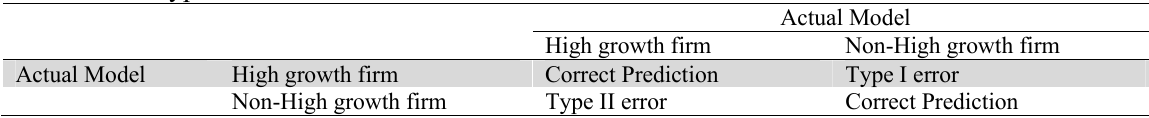
Overview of Type of